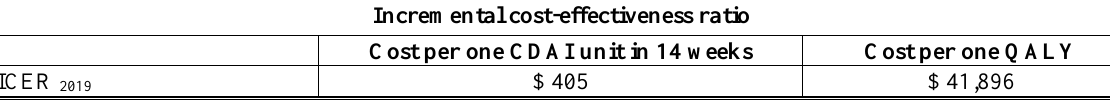
Table 11. The incremental cost-effectiveness ratio (ICER) of Remicade to Remsima. Incremental cost-effectiveness